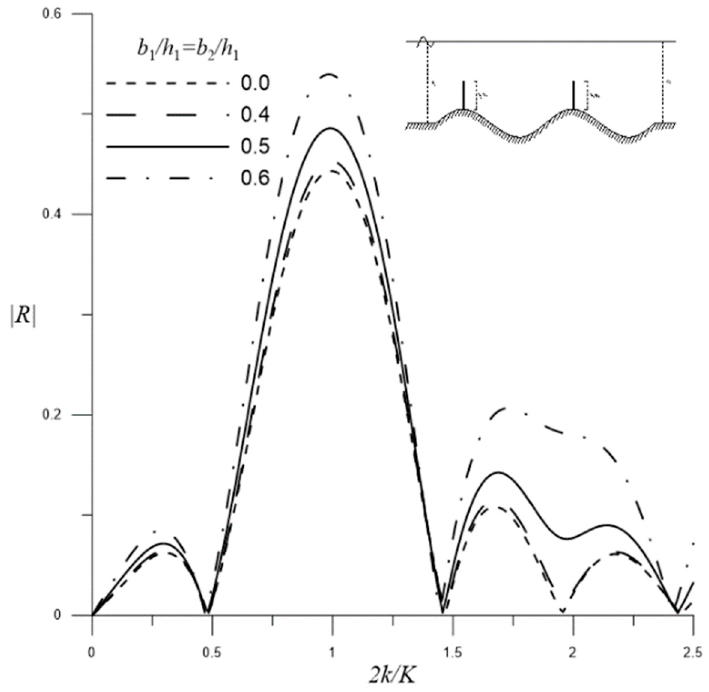
Figure 15. Reflection coefficient | R | varying against 2 k / K for different values of a 1 / h 1 and a 2 / h 1 .